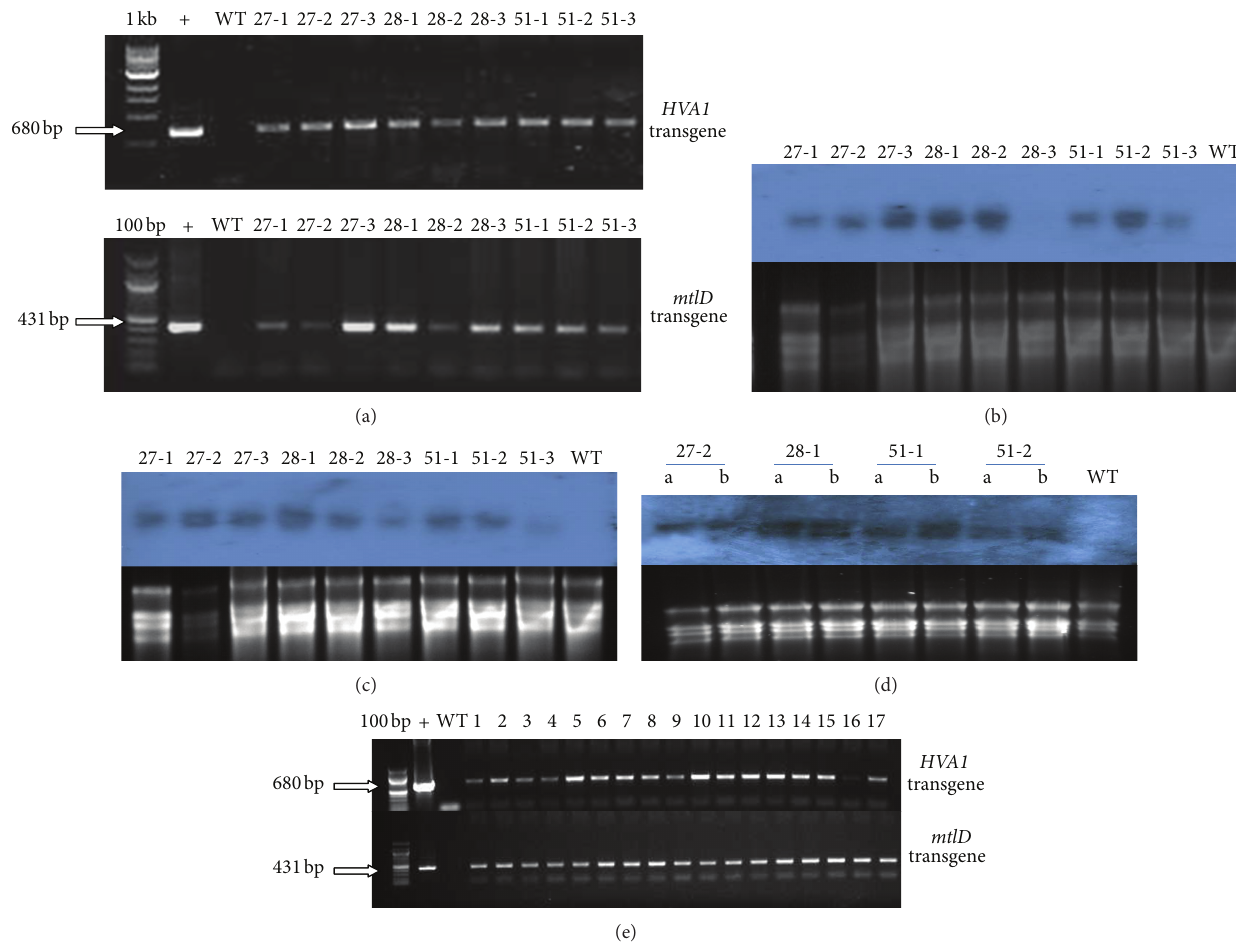
Figure 3: (a) PCR analysis of the combination of HVA1 - mtlD in T1 maize lines. (b) Northern blot hybridization of T1 HVA1 in HVA1-mtlD transgenic lines using the HVA1 probe. (c) Northern blot hybridization of T1 mtlD in the HVA1-mtlD transgenic lines using the mtlD probe. (d) Northern blot hybridization of T2 HVA1 in HVA1-mtlD transgenic lines using the HVA1 probe. (e) RCR analysis of the T3 HVA1-mtlD confirming the stability of both transgenes in the fourth (T3) progeny obtained from northern blot positive HVA1 and mtlD T2 line number